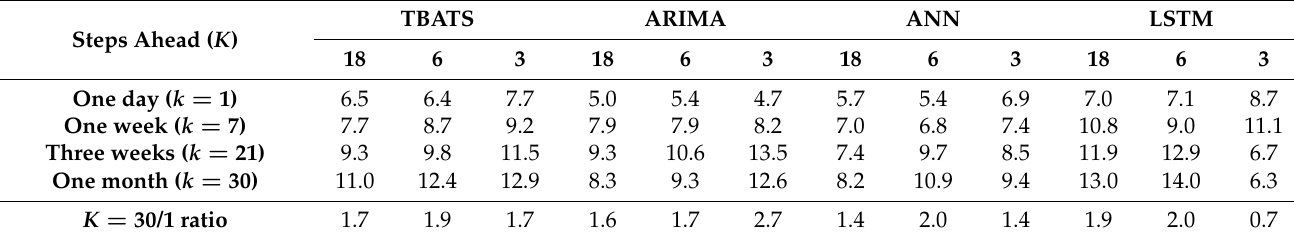
Table 6. Accuracy of rolling forecasting with different historical lengths (3, 6, and 18 months) at the national scale. Steps Ahead ( K ) One day ( k = 1) One week ( k = 7) Three weeks ( k =